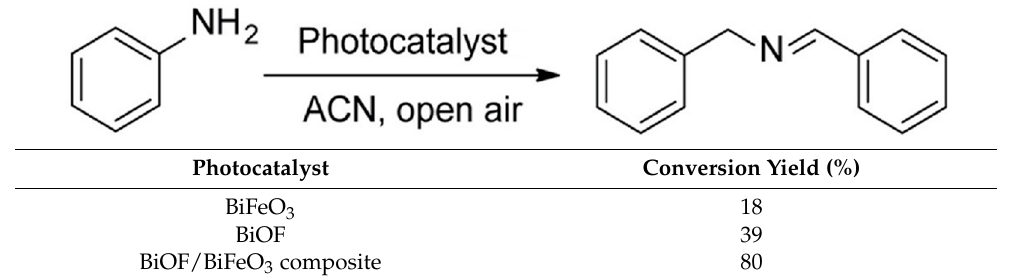
Table 1. Photocatalytic coupling of benzylamine to N -benzylidenebenzylamine over BiFeO 3 , BiOF, and BiFeO 3 /BiOF composite.